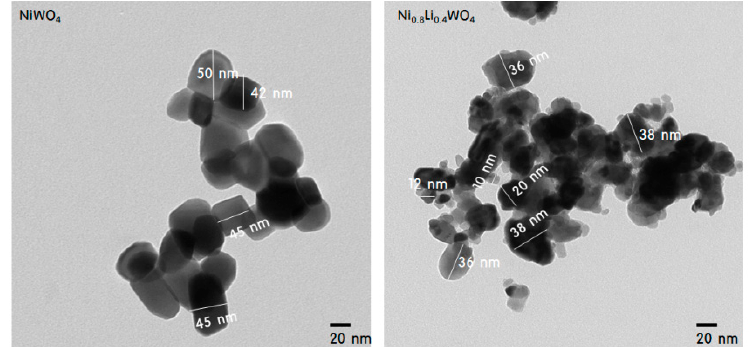
Figure 3. TEM images of NiWO 4 and Ni 0.8 Li 0.4 WO 4 particles.